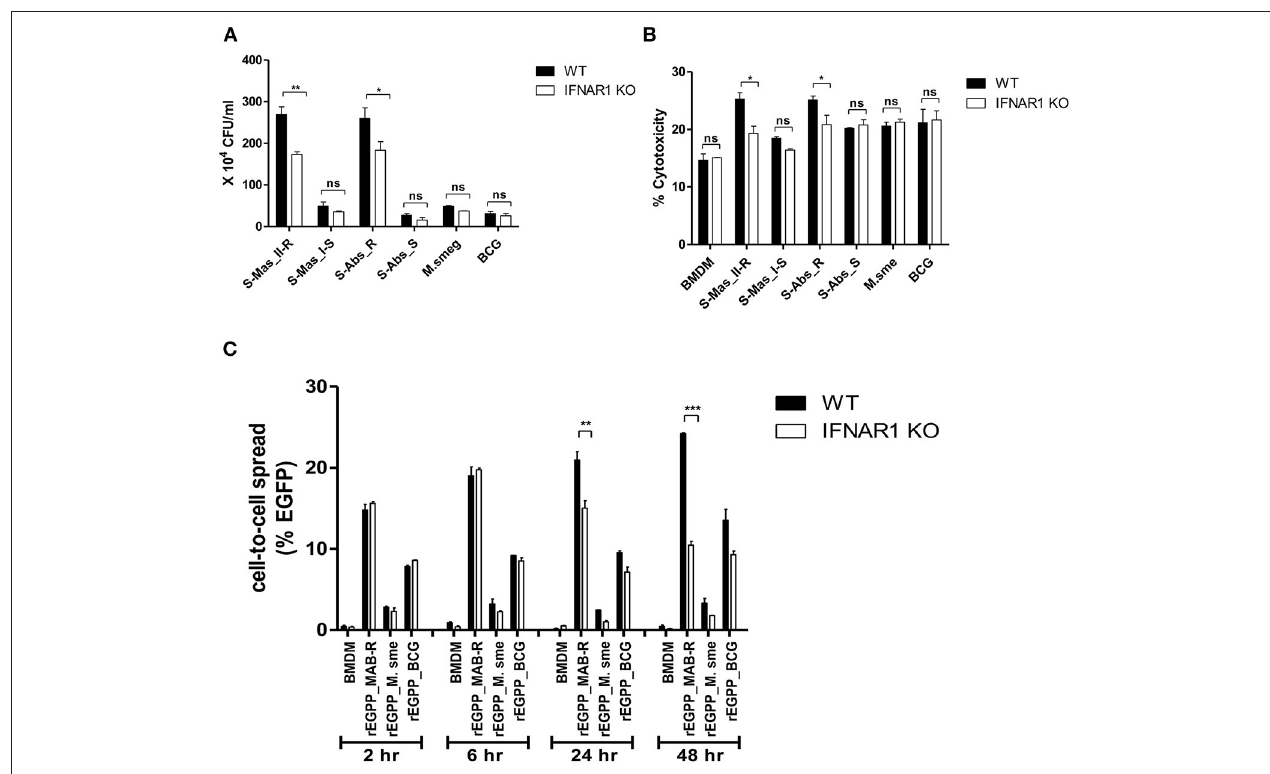
FIGURE 7 | The cell-to-cell spread in MAB-R infection depends on Type I IFN signaling. (A,B) BMDMs (WT and IFNAR1 KO mice) infected with rough strains R [S-Abs_R ( M. abscessus type strain ATCC 19977 rough strain)] and smooth strains [S-Abs_S ( M. abscessus type strain ATCC 19977 smooth strain) and S-Mas_I-S (Asan 51843)], M. smegmatis , or M. bovis BCG (10M.O.I) for 24h. Infected cell lysate was used for CFU assays. Supernatants were collected and cytotoxicity was measured by LDH assay. (C) BMDMs (WT and IFNAR1 KO mice) infected with EGFP-expressing bacteria [rEGFP_MAB-R (Asan 50594), rEGFP_M.smeg, rEGFP_BCG] (10M.O.I) measured at different time points (2, 6, 24, and 48h). Infected cells were collected and the percentage of EGFP-positive cells was evaluated by flow cytometry (FACScalibur). The results are representative of two independent experiments and represent means ± SD. P -values were determined by